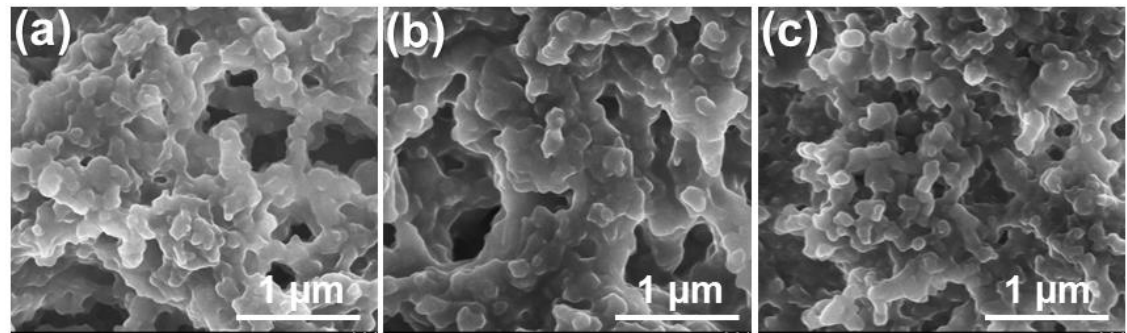
Figure 1. SEM images of Se NPs synthesized by the CO extract with the assistance of ( a ) probe sonicating, ( b ) bath sonicating, and ( c ) magnetic stirring with Se 4+ /CO volume ratio of 1/1.